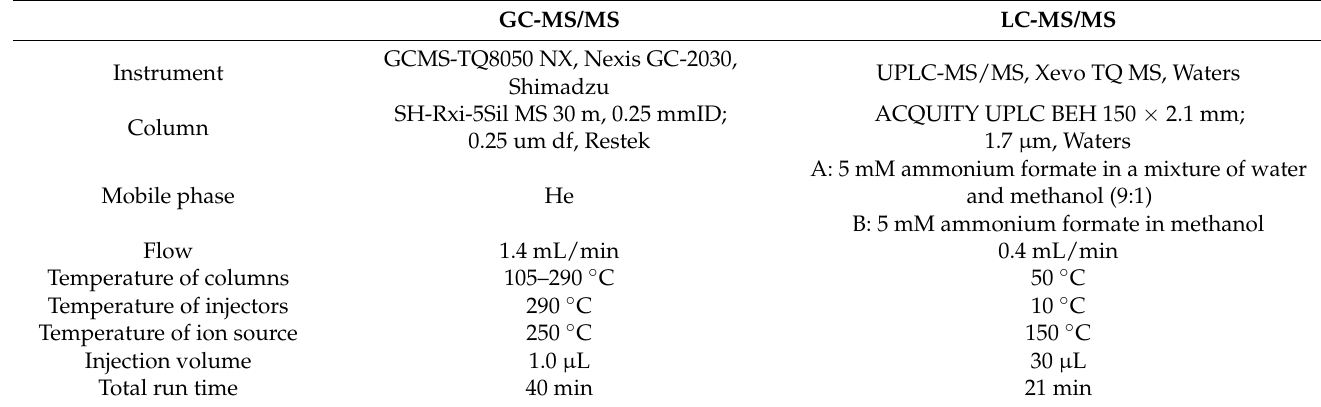
Table 1. Chromatographic conditions of GC-MS/MS and LC-MS/MS.